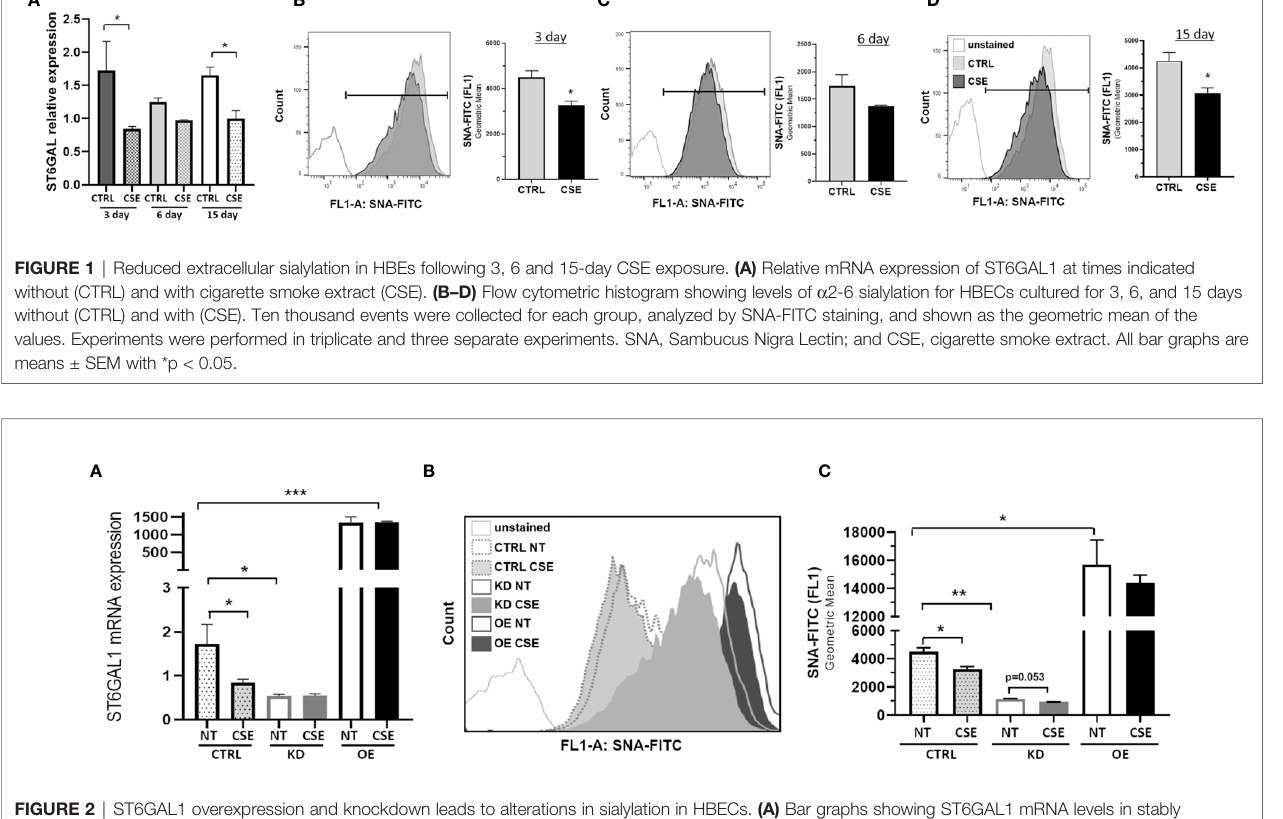
FIGURE 2 | ST6GAL1 overexpression and knockdown leads to alterations in sialylation in HBECs. (A) Bar graphs showing ST6GAL1 mRNA levels in stably transfected ST6GAL1 KD and OE cultures compared to control (CRTL) infected cells in the presence or absence of CSE. (B) Flow cytometric analysis of a 2-6 sialylation using SNA-FITC labeling of HBECs (CTRL, ST6GAL1 KD, and ST6GAL1 OE) following treatment with and without CSE for 3 days. (C) Graphical data of the 10,000 events that were collected from (B) for each group and analyzed. Abbrv. SNA, Sambucus Nigra Lectin; CTRL, pLKO vector control; KD, ST6GAL1 knockdown; and OE, ST6GAL1 overexpression; NT, no treatment; CSE, cigarette smoke extract; and HBECs, human bronchial epithelial cells. Experiments were performed in triplicate using three separate experiments. All bar graphs are means ± SEM with *p < 0.05, **p < 0.01 and ***p <